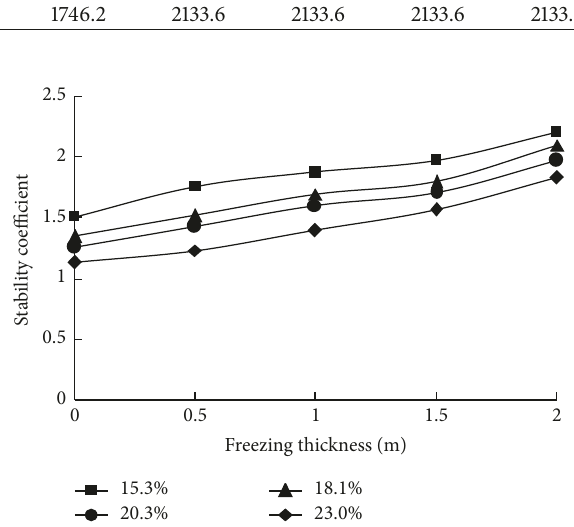
Figure 10: Variation of stability coefficient with freezing depth.